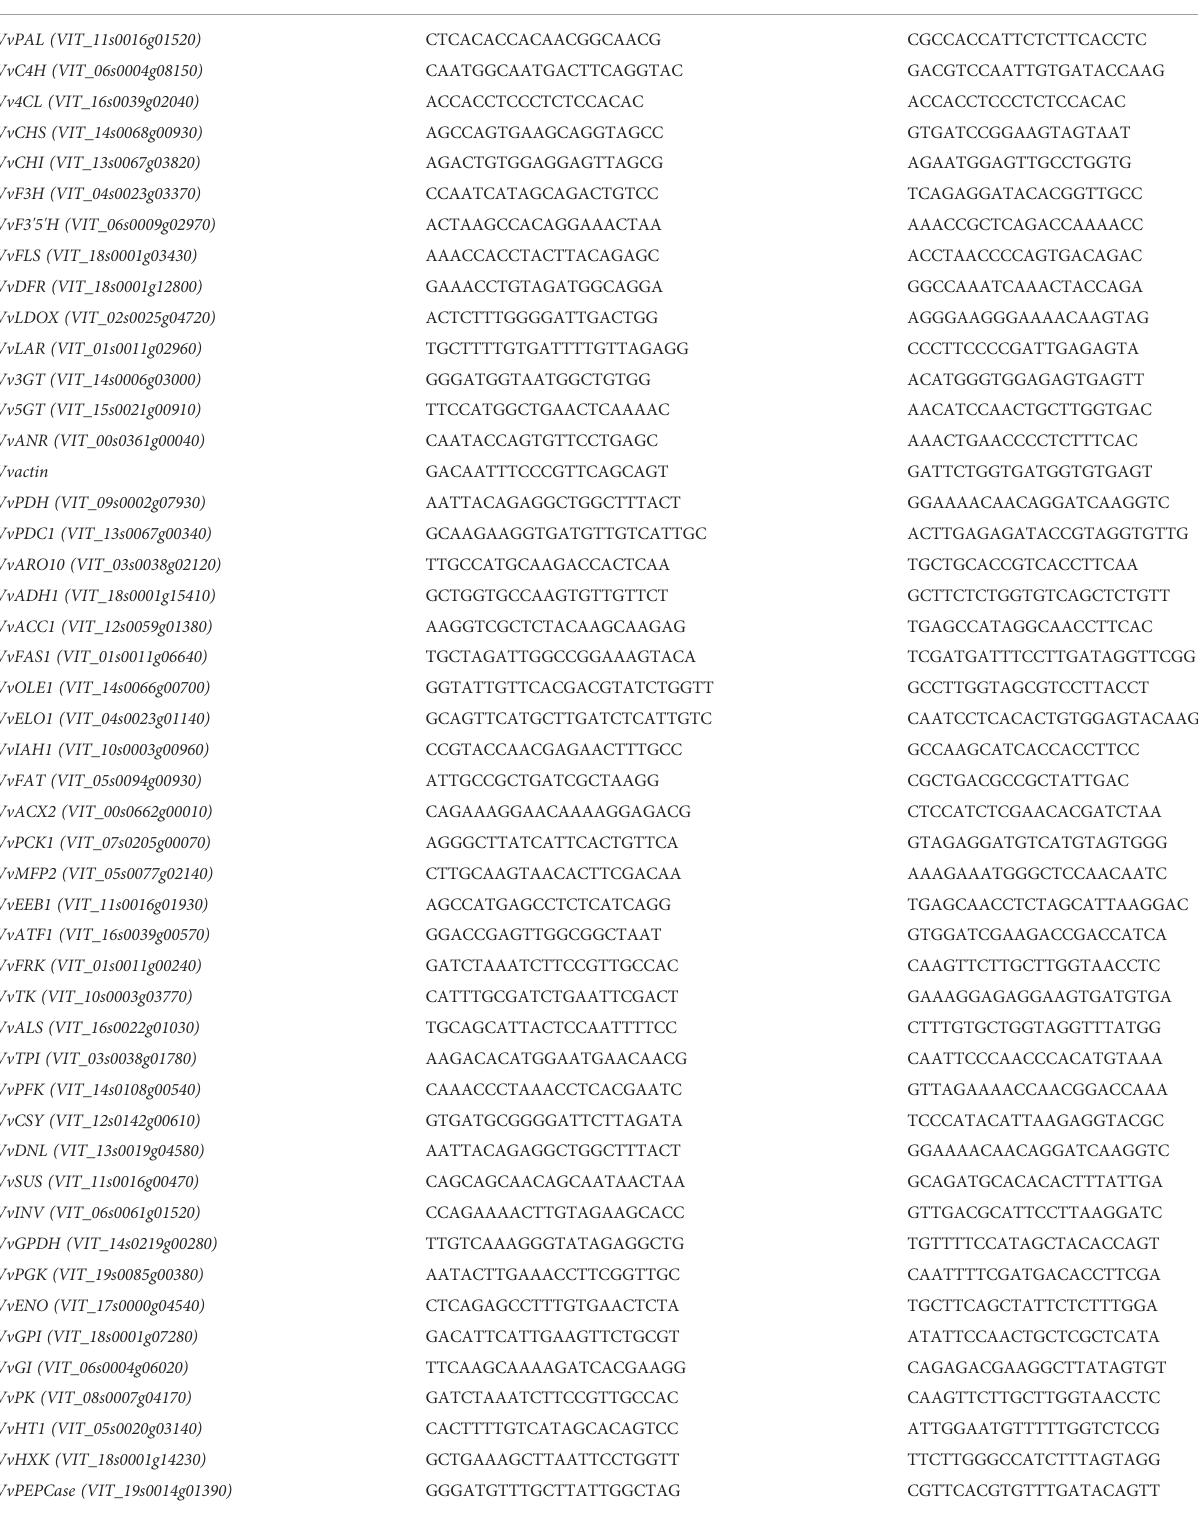
TABLE 1 Primers for qRT-PCR, all primers were designed by Primer Premier 5.0 and qPrimerDB-qPCR Primer Database. Target